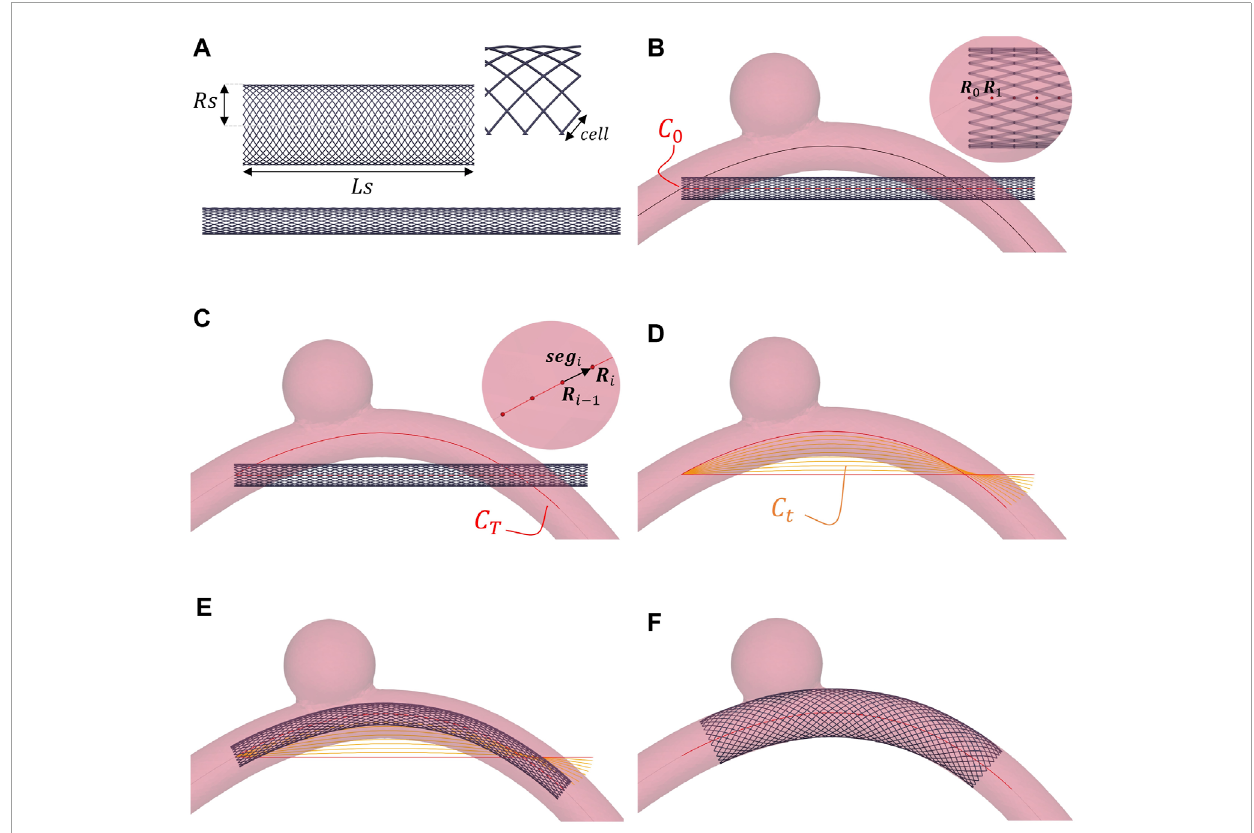
FIGURE 2 Stent deployment strategy. The wire thickness is magnified ( 2 ×) to better visualize the stent. (A) Free and crimped stent. (B) Crimped stent and initially straight centerline ( C 0 ) . (C) Final centerline of the stent ( C T ) . (D) Intermediate centerlines ( C t ) . (E) Positioned stent. (F) Deployed